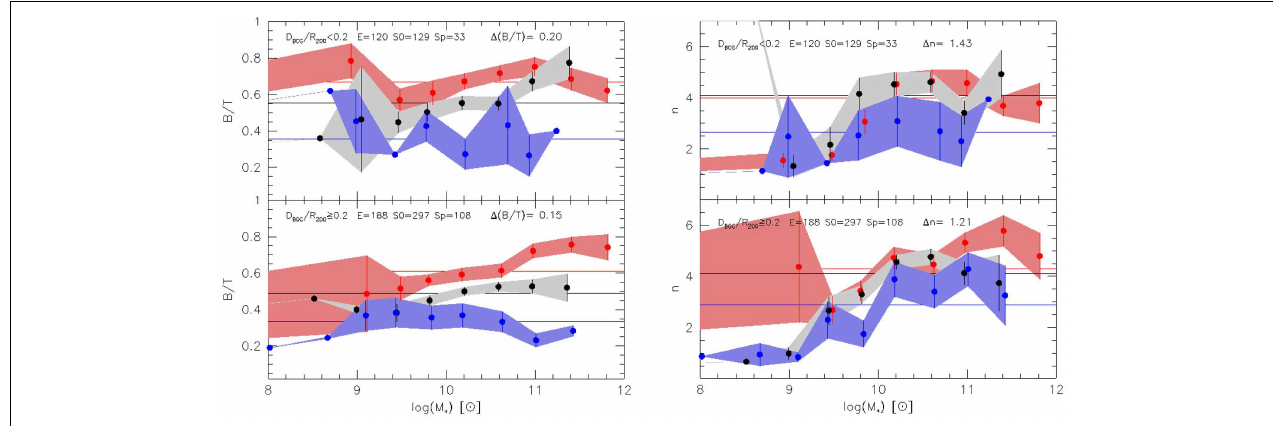
FIGURE 17 | Left: The B/T ratios of the various morphological types in the two bin of cluster-centric distance. Right: The Sérsic index of the bulge components of the galaxies.